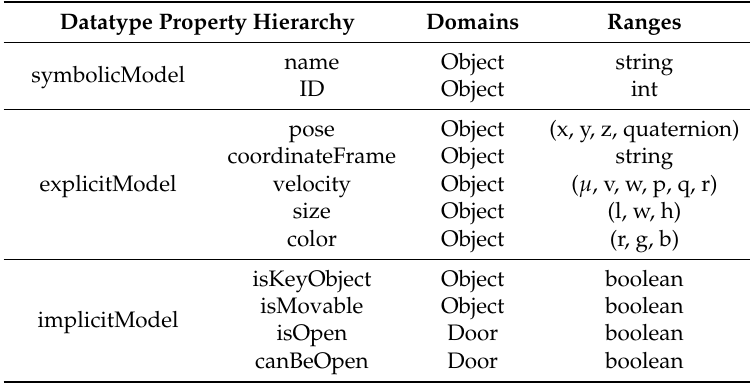
Table 3. Datatype properties for Object